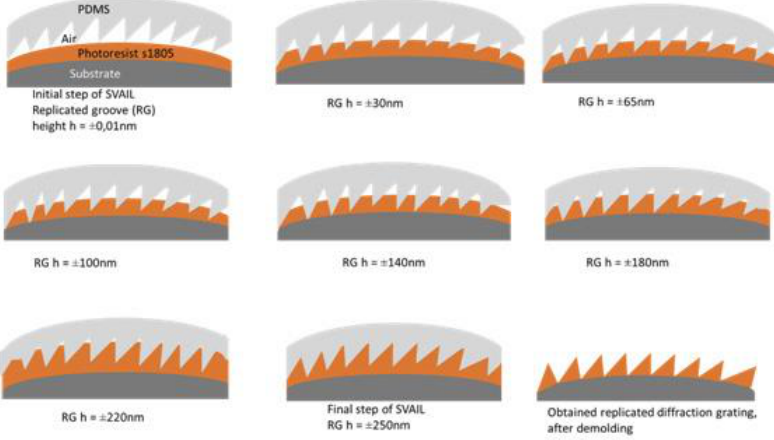
Figure 9. Evolutionary representation of replication groove (RG) height during SVAIL replication [82].